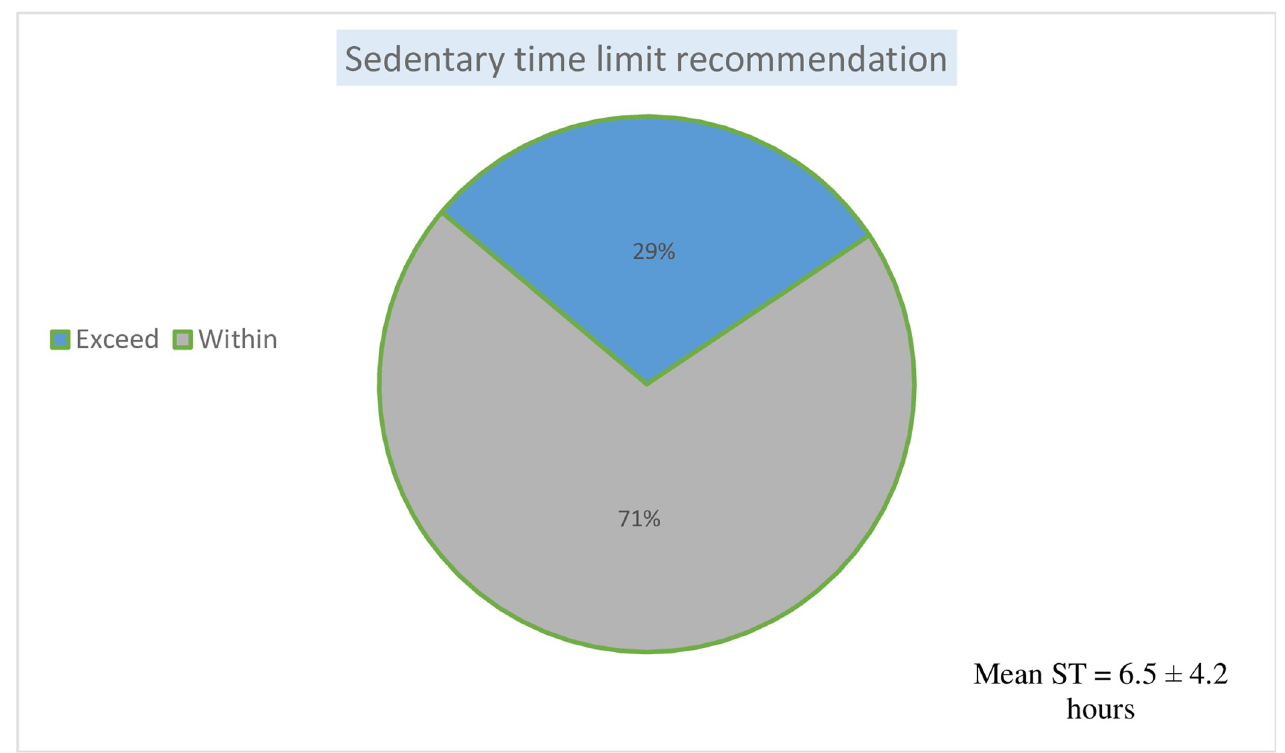
Fig 3. Proportion of women that exceed the recommended sedentary time limit by pregnant women in Ibadan, Nigeria.